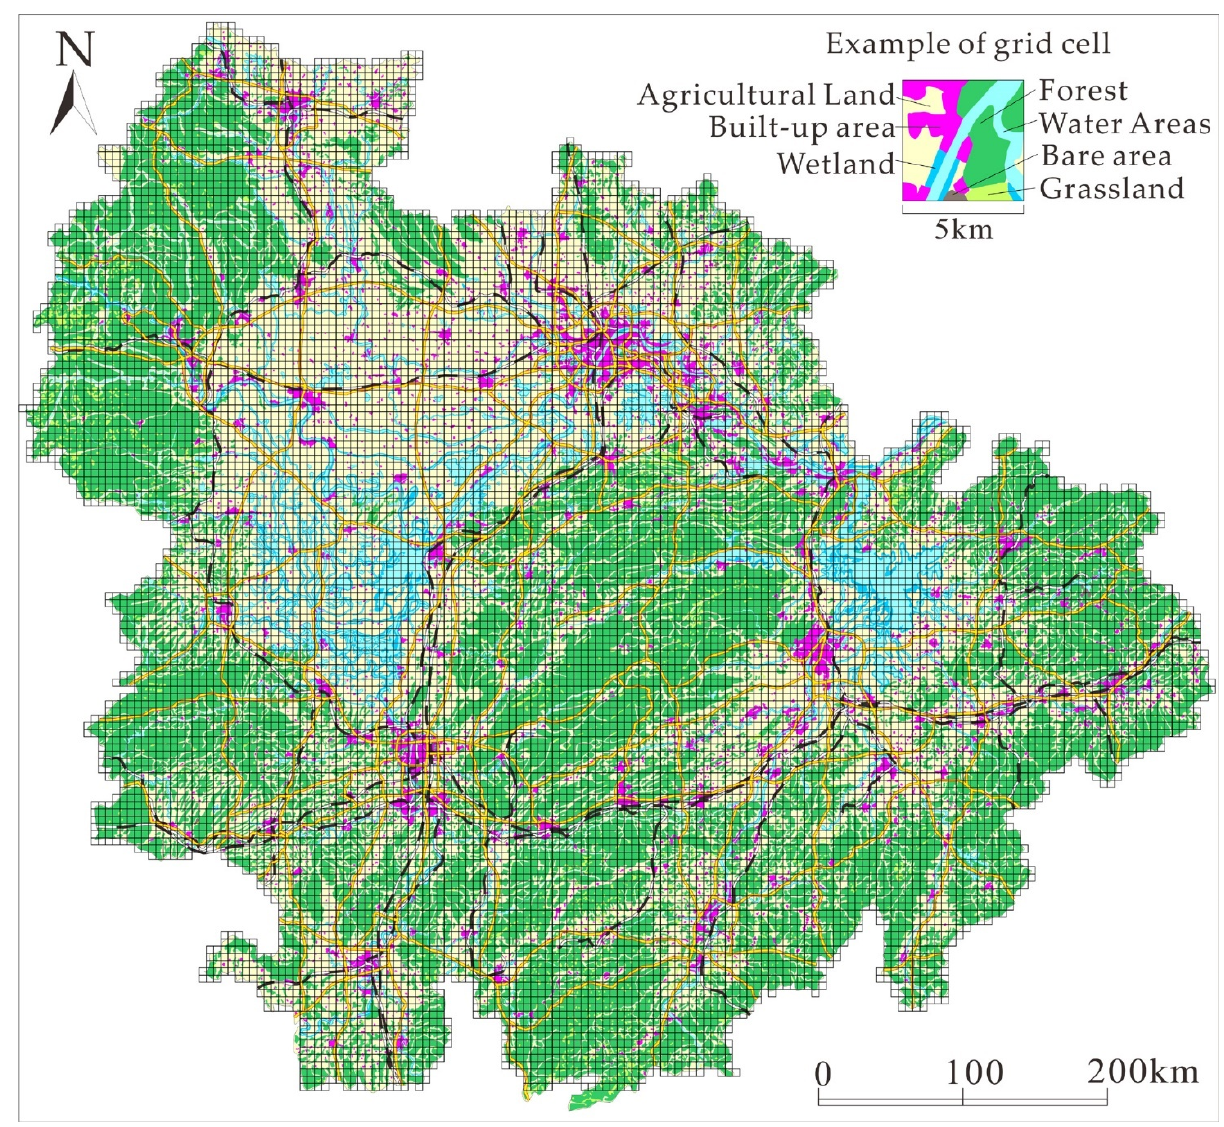
Figure 2. Grid system of UAMRYR and the example of grid cell.